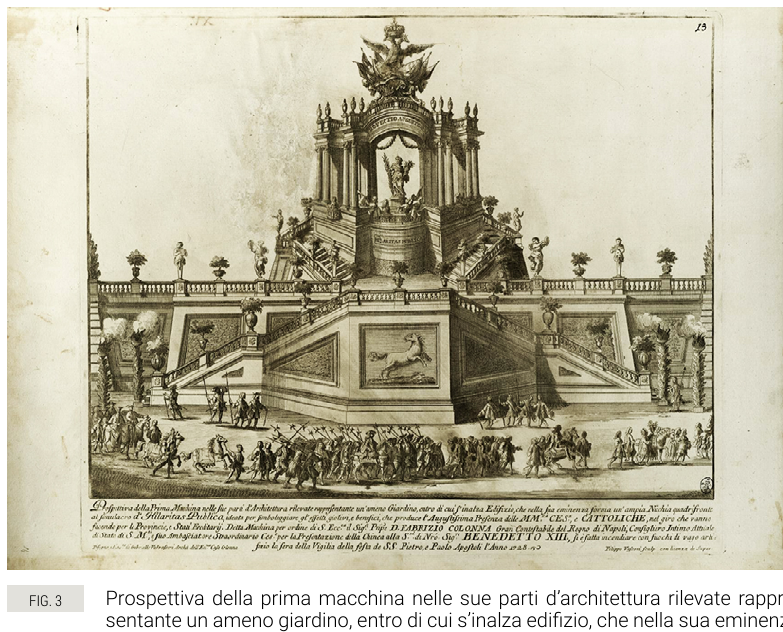
Prospettiva della prima macchina nelle sue parti d’architettura rilevate rappre- sentante un ameno giardino, entro di cui s’inalza edifizio, che nella sua eminenza forma un’ampia nicchia quadrifronte al simulacro di Hilaritas Publica, (Vasconi F., 1728), ©Biblioteca Casanatense,